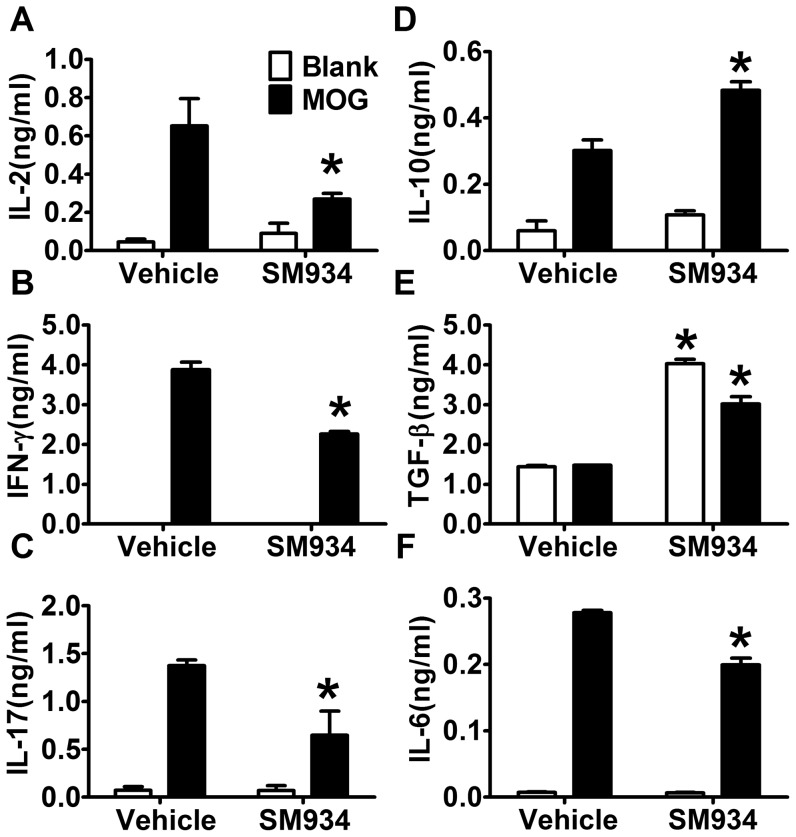
SM934 treatment suppressed MOG-specific pro-inflammatory cytokines and enhanced MOG-specific anti-inflammatory cytokines production in splenocytes from EAE mice.Splenocytes from immunized mice treated with vehicle or SM934 (10 mice per group) were isolated at the peak of disease (day 18 p.i.), re-stimulated with MOG35–55 (10 µg/ml) for 72 hours. Culture supernatants were collected and indicated cytokine levels were measured by ELISA. Results were expressed as mean ± SEM. *, p<0.05 compared with vehicle control. Three independent experiments were performed with similar results.